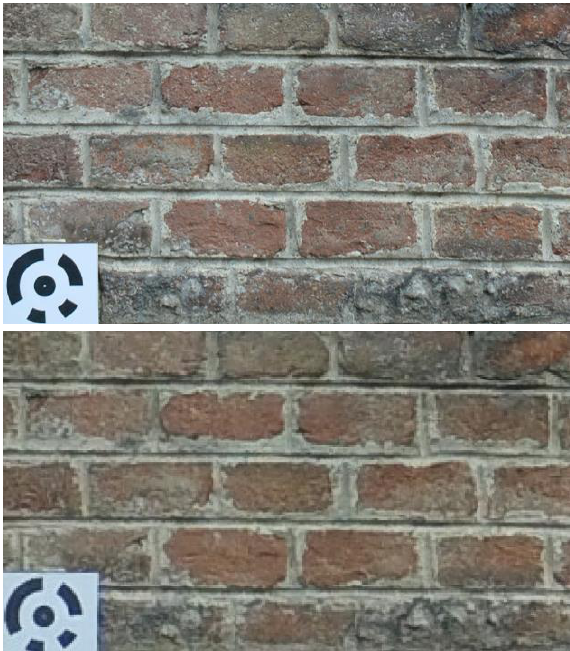
Figure 9. Orthophotos with pinhole (top) and spherical (bottom)